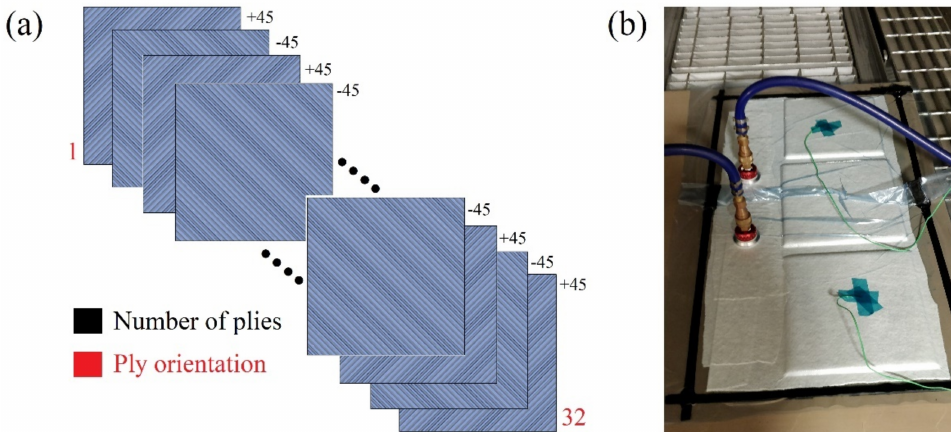
Figure 1. ( a ) Ply configuration for one of the glass fibre plates used in the study [+ 45/ − 45 ] ( b ) Manufacturing setup of the workpiece inside the autoclave.